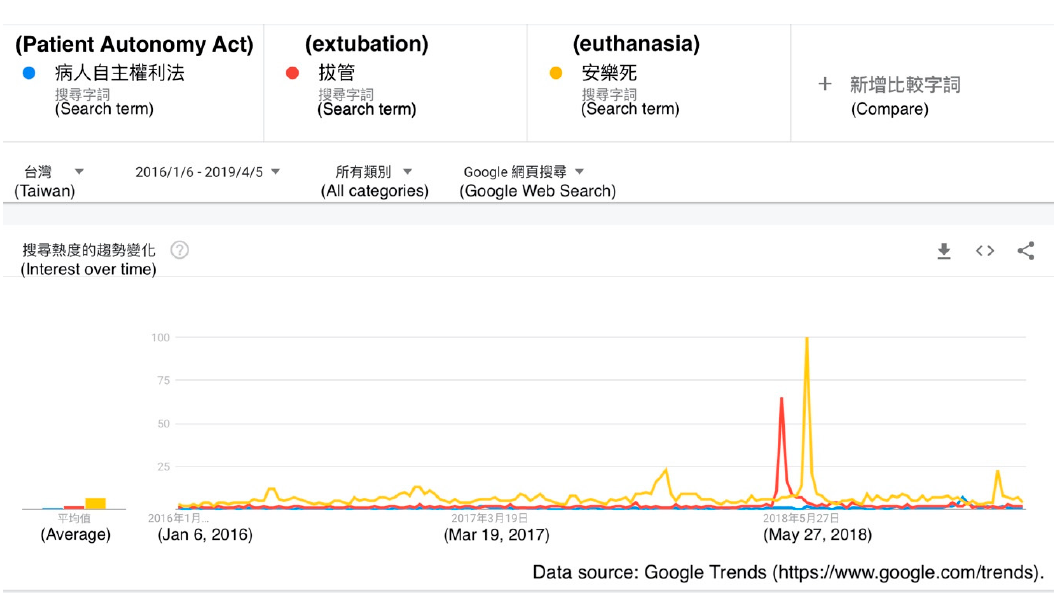
Figure 3. A Google Trends graph for the terms “hospice” (blue line), “hospice ward” (red line), “palliative care” (yellow line), “do not resuscitate” (purple line), and “DNR” (green line) in Taiwan from 6 January 2016 to 5 April 2019.